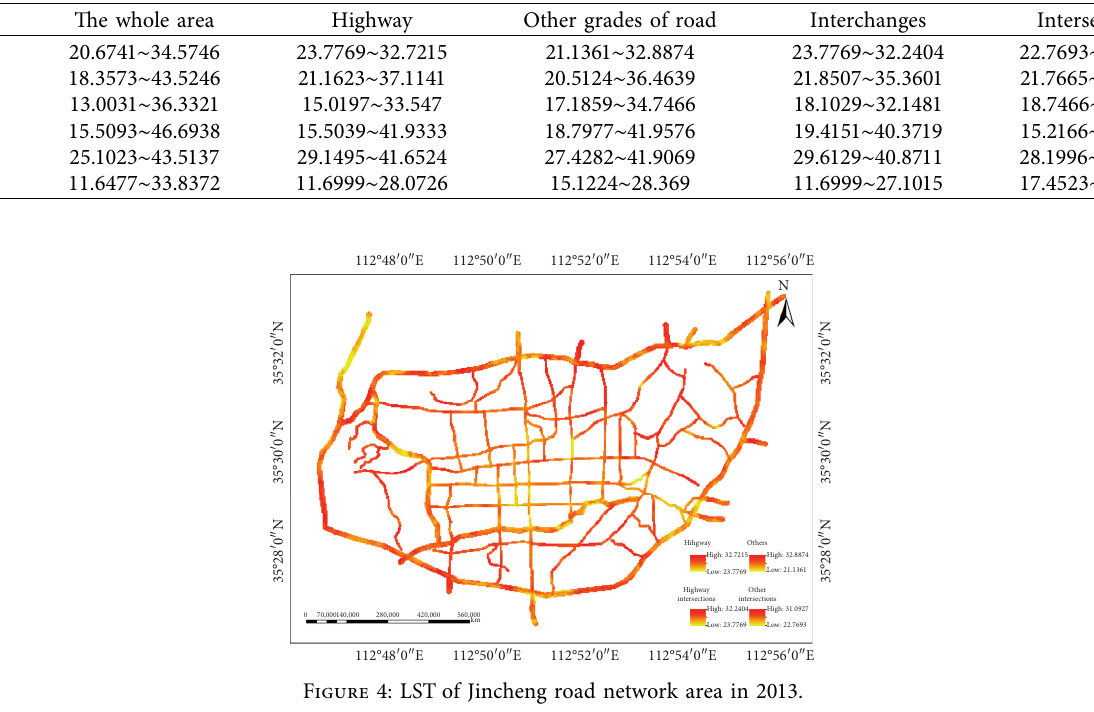
Table 2: LST of the study areas from 2013 to 2018.